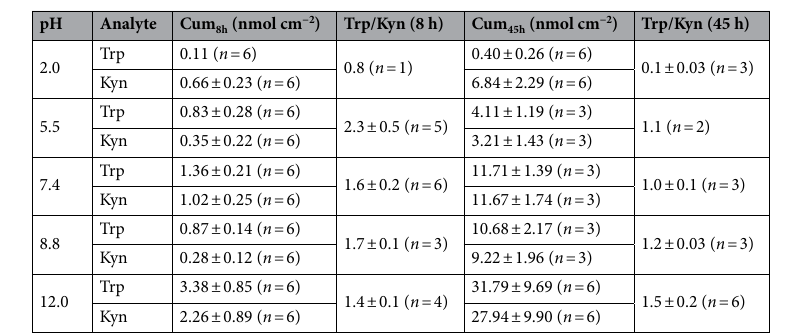
Table 1. Summary of the results from the permeability studies of Trp and Kyn (cf. Fig. 2). Note that the Trp/ Kyn ratio is based on the cumulative amount of each permeant in the receptor solution after 8 h or 45 h.